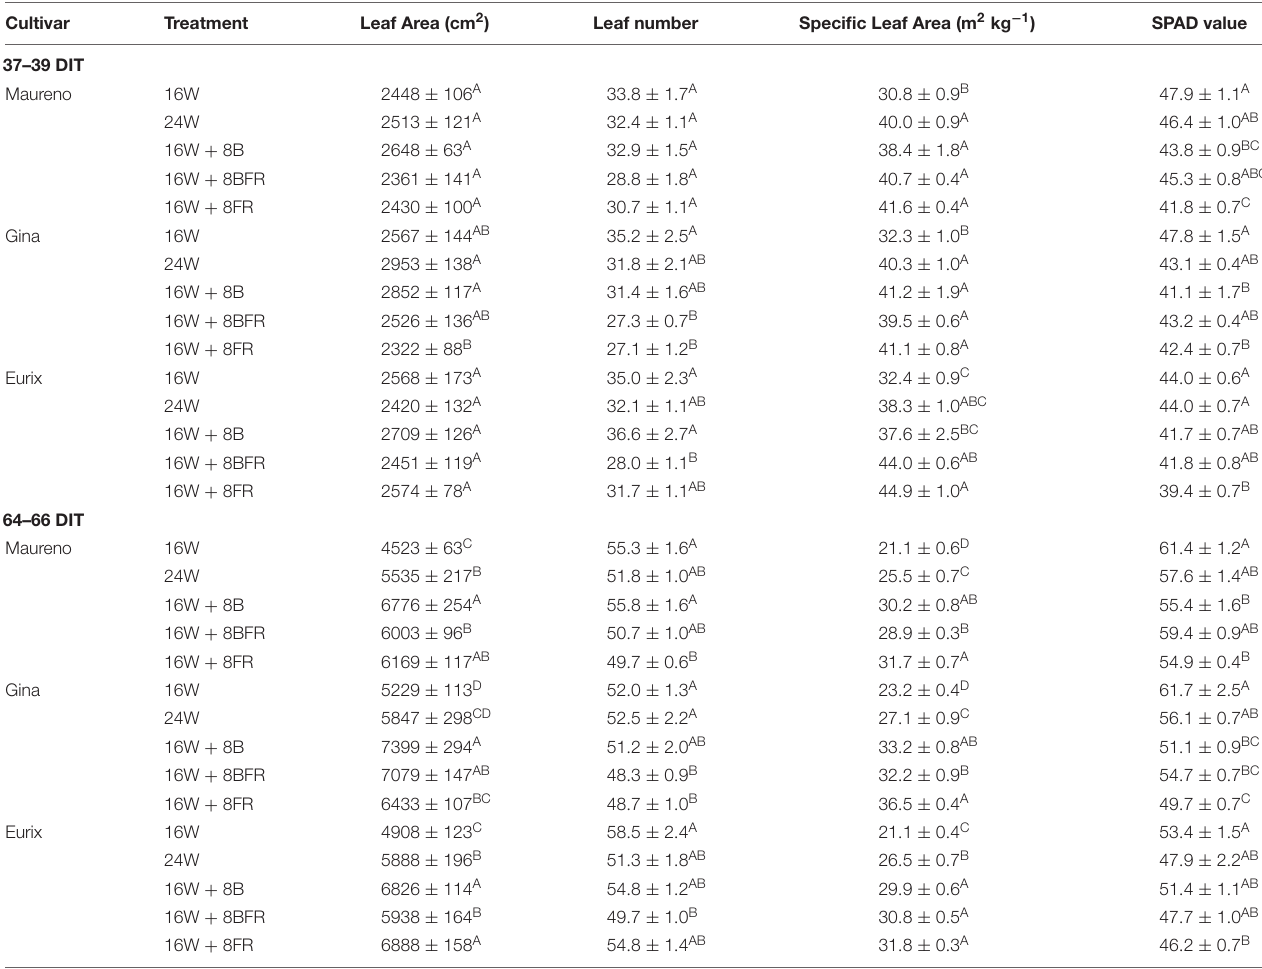
TABLE 3 | Leaf area, leaf number, specific leaf area, and SPAD value of ‘Maureno,’ ‘Gina,’ and ‘Eurix’ during the 37–39 DIT and 64–66 DIT measurement periods under different light treatments. Cultivar